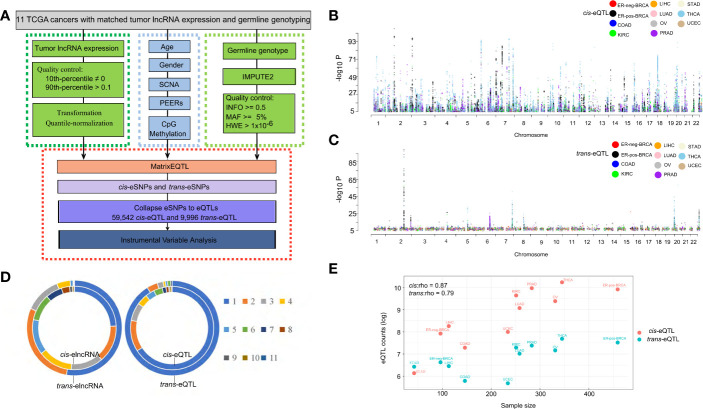
Expression of QTLs in TCGA cancer types. (A) Schematic plot showing the eQTL mapping workflow to identify the associations between germline genotype and tumor lncRNA expression in 11 cancer types. (B) Manhattan plot of cis-eQTLs in 11 cancer types showing -log10 P-values of cis-eQTLs in autosomes. Each dot represents a significant eQTL. (C) Manhattan plot of trans-eQTLs in 11 cancer types showing -log10 P-values of trans-eQTLs across the autosome. Each dot represents a significant eQTL. (D) Ring diagram showing the common cis/trans-eQTLs and cis/trans-elncRNAs across cancer types. “1” represents eQTLs occurring in one cancer type while “11” represents eQTLs occurring in 11 cancer types. (E) Log counts of cis/trans-eQTLs in each cancer type are positively correlated with sample size.